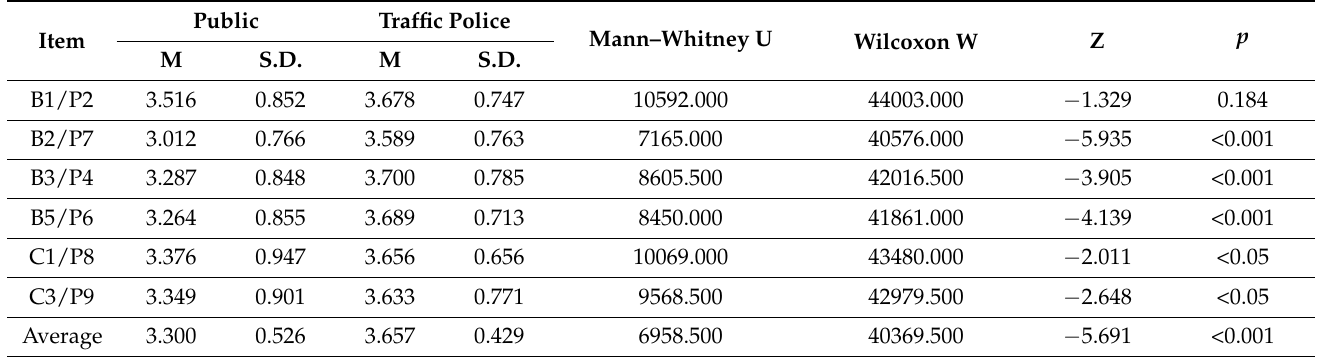
Table 10. Mann–Whitney U test results of the same items by public and traffic police